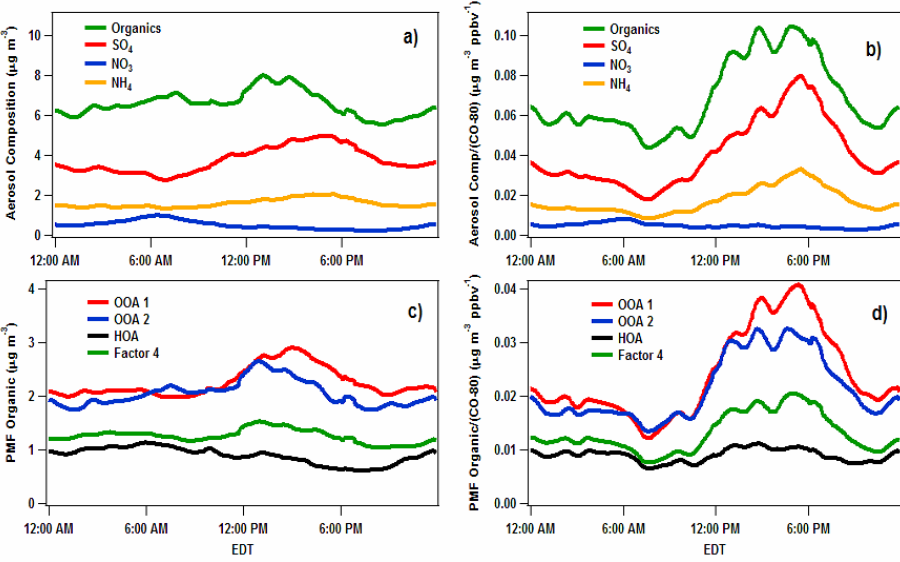
Figure 8. Diurnal profiles of AMS species (upper frames, a and b) and AMS organic PMF factors (lower frames, c and d), without normalization to CO less its regional Fig. 8. Diurnal profiles of AMS species (upper frames, a and b ) and AMS organic PMF factors (lower frames, c and d ), without normalization to CO less its regional background value (left frames, a and c ) and with normalization (right frames, b and d ). background value (left frames, a and c) and with normalization (right frames, b and d) of sites worldwide (Zhang et al., 2007). Of the 38